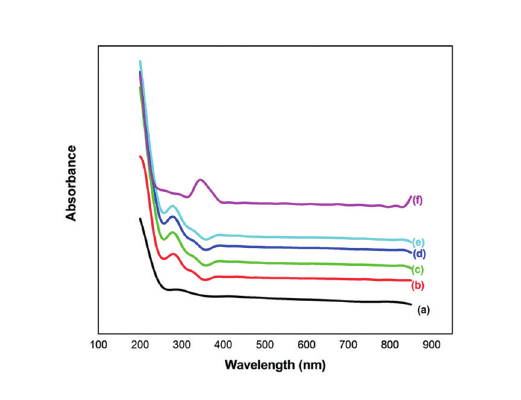
Figure 5: UV-Vis absorption spectra of pure and Mn 2+ doped PVC polymer films (a) Pure (b) 1mol % (c) 2 mol % (d) 3 mol % (e) 4 mol% (f) 5 mol%.